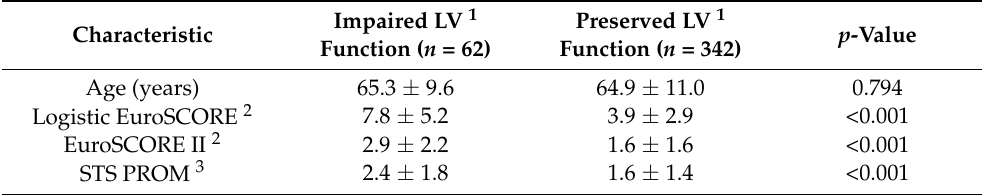
Table 1. Baseline